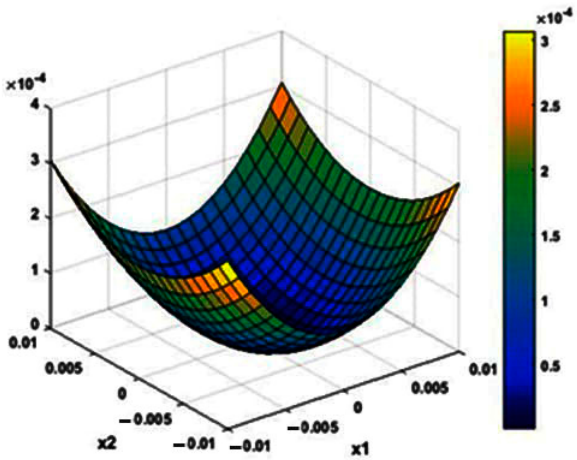
Figure 8. Surface h ( x ) for small range of x 1 ( t ), x 2 ( t ) and check the condition h ( x ) > 0 for stability nonlinear time-variant system (39).